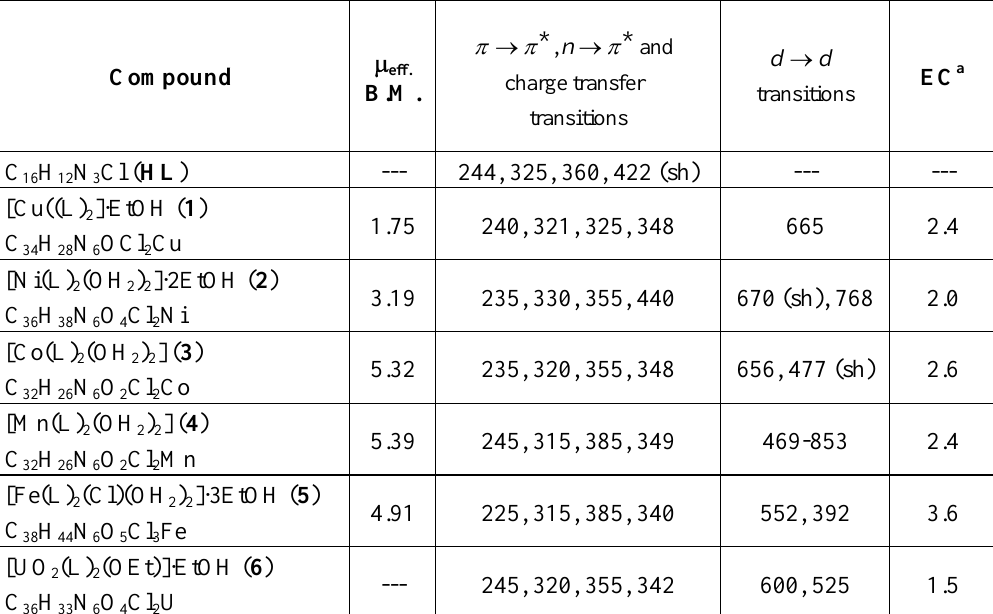
Table 4. Magnetic moment, spectral data (nm) and conductance measurements of HL and its metal